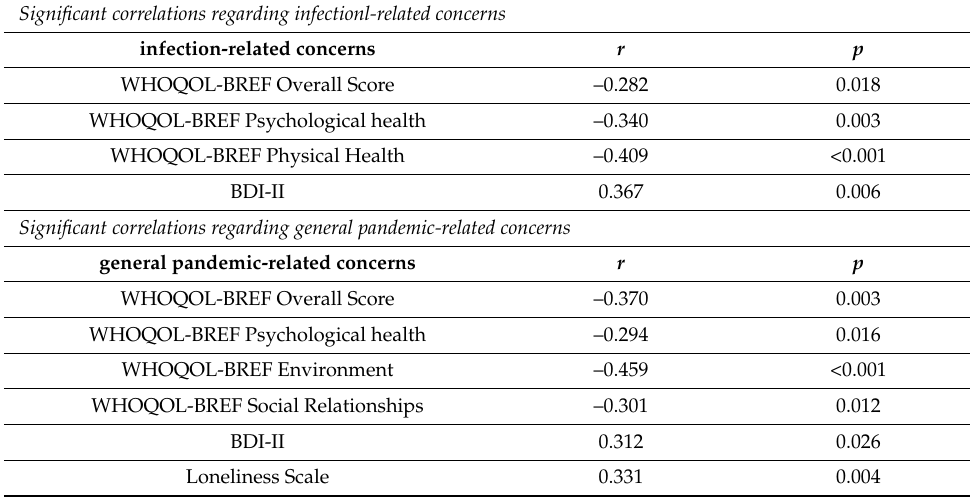
Table 7. Significant correlations regarding pandemic related concerns “Long